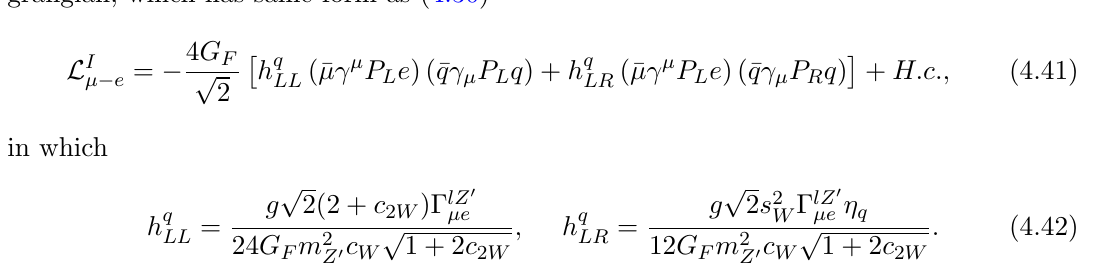
In the considering model, the (cid:22) (cid:0) e conversing ratio can be calculated from a La- grangian, which has same form as